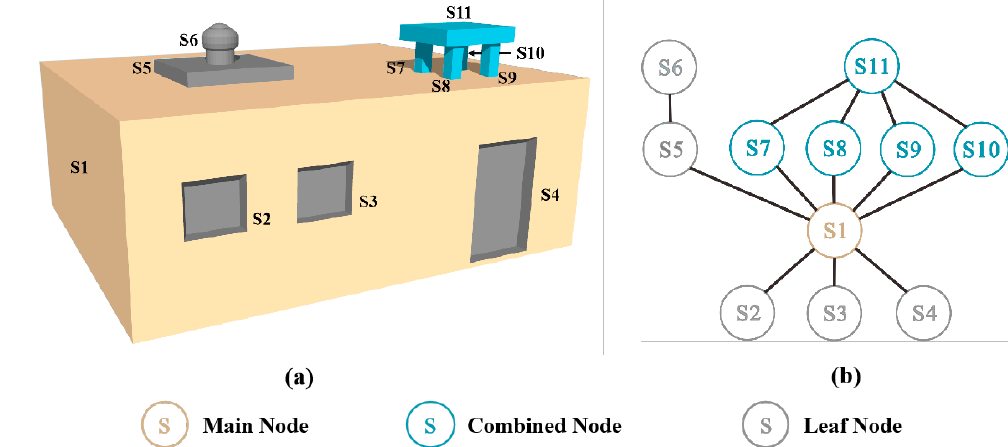
Figure 6. Schematic diagram of the transmission node construction. ( a ) The structure of the building model, and ( b ) STG. In STG, structures are wrapped as different transmission nodes.